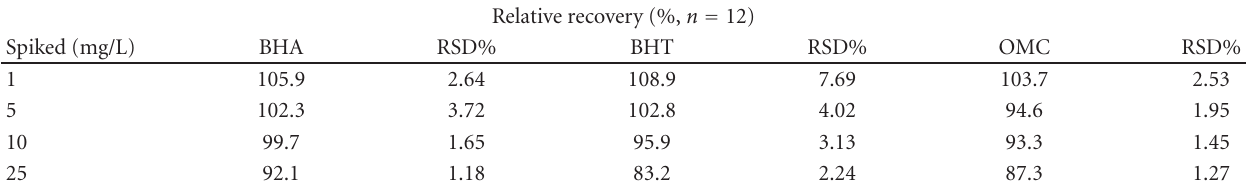
Table 4: Results of recovery study for BHA, BHT, and OMC by RP-HPLC-UV/Vis at λ max = 280